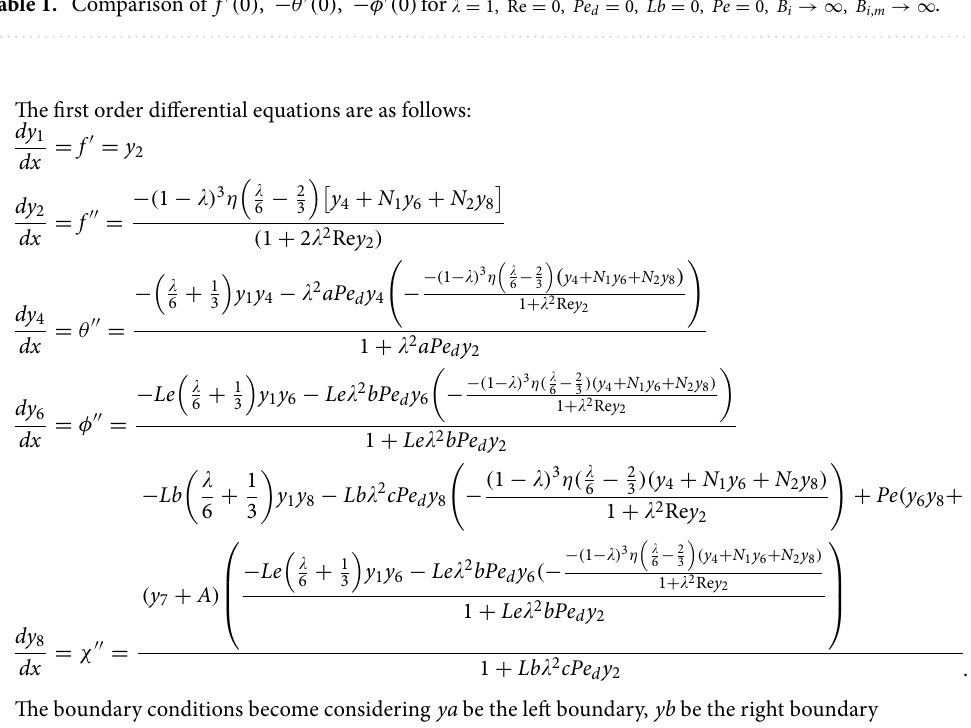
Table 1. Comparison of f ′ ( 0 ) , − θ ′ ( 0 ) , − φ ′ ( 0 ) for (cid:31) = 1, Re = 0, Pe d = 0, Lb = 0, Pe = 0, B i → ∞ , B i , m → ∞ .